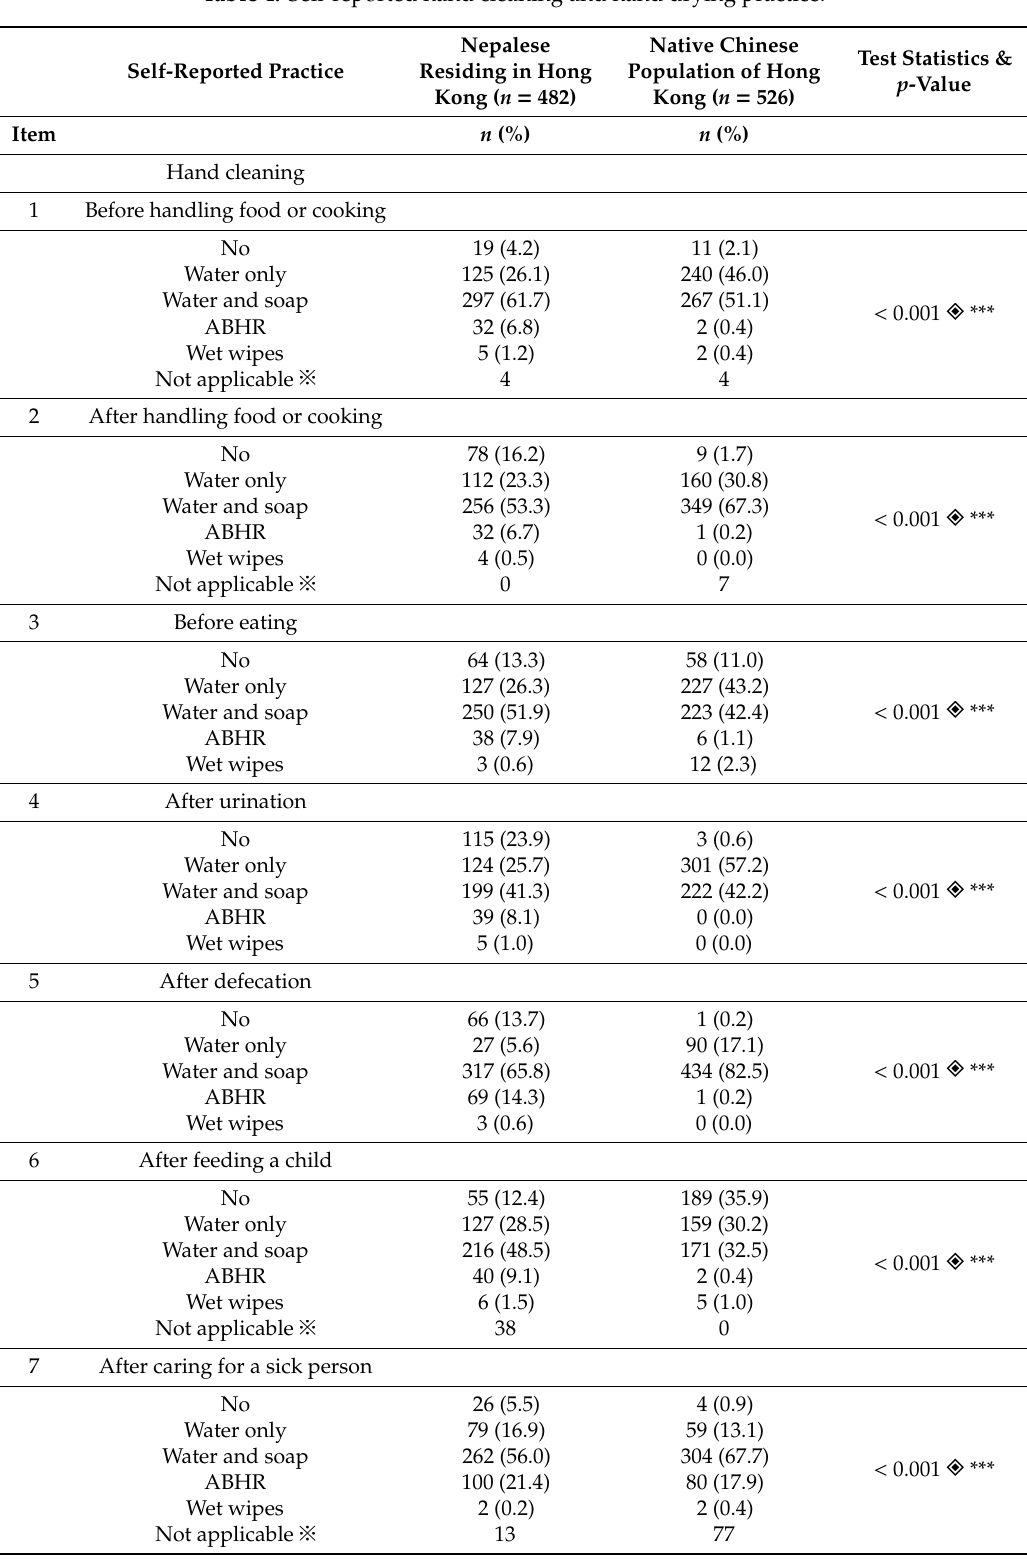
Table 4. Self-reported hand cleaning and hand drying practice.